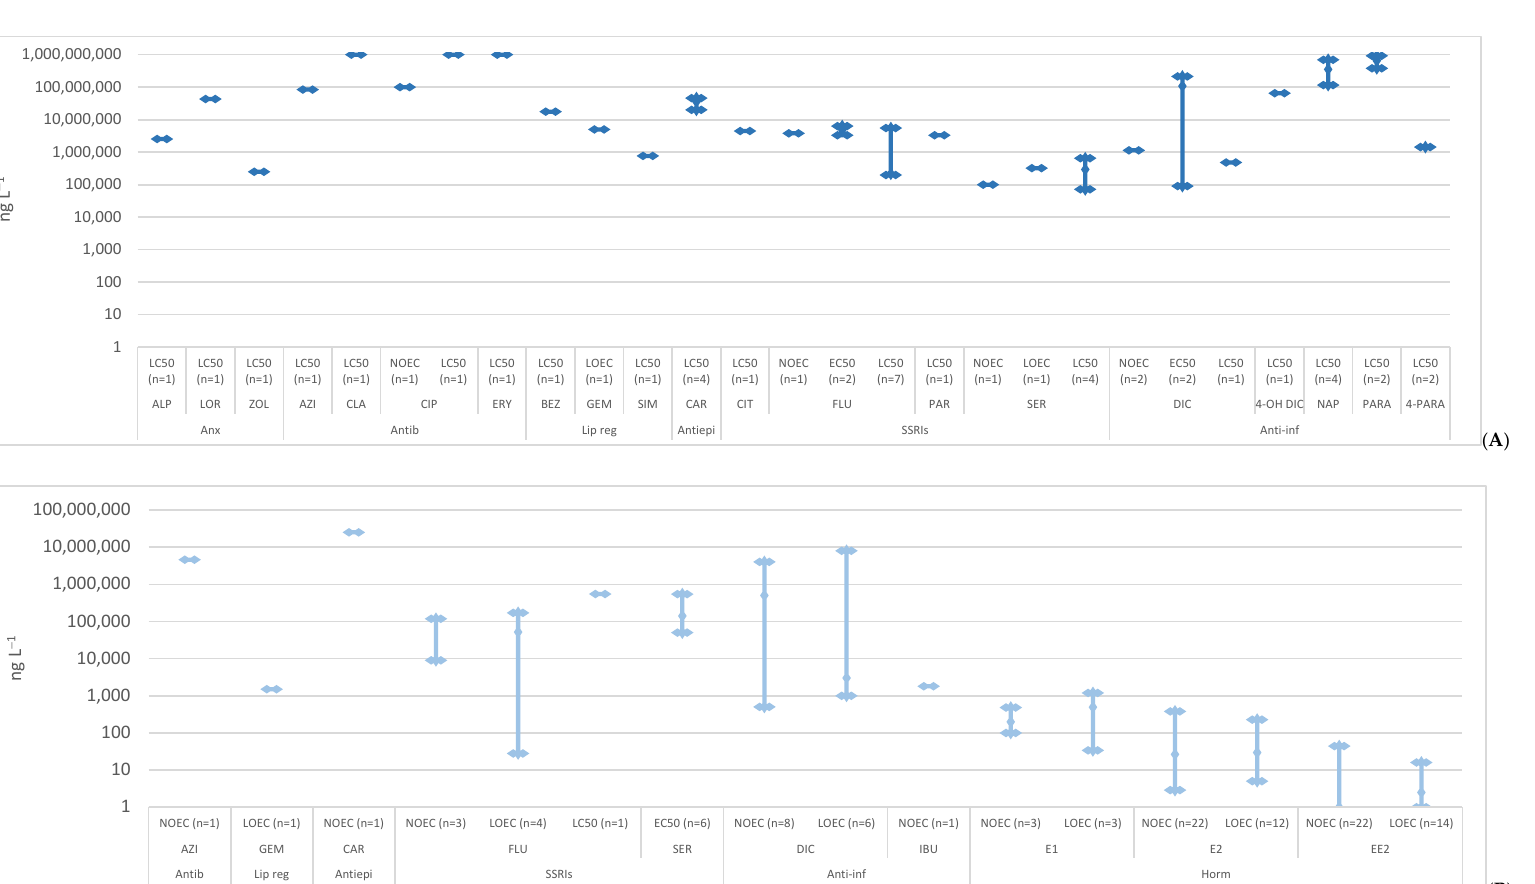
Figure 2. Median, maximum and minimum concentration values reported for acute ( A ) and chronic ( B ) toxicity data concerning invertebrates. (Anx—anxiolytics; Antib—antibiotics; Lip reg—lipid regulators; Antiepi—antiepileptics; SSRIs—Selective serotonin reuptake inhibitors; Anti-inf—anti- inflammatories; Horm—hormones) [23,27–32,35,36,40–42,44,46,51–84].